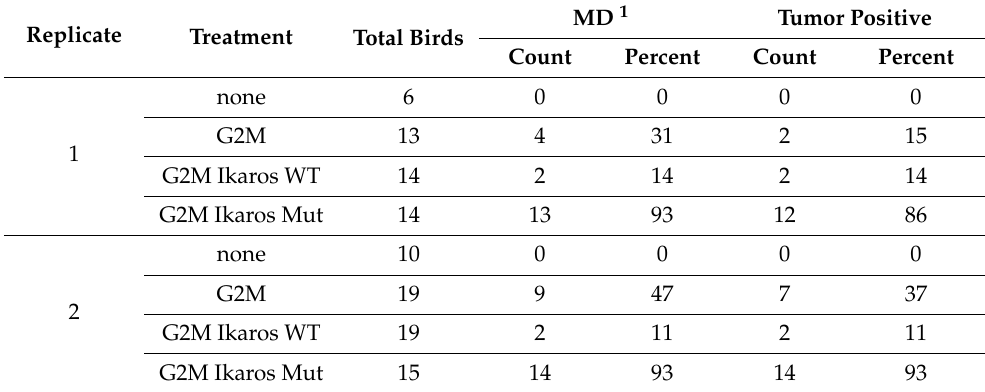
Table 2. Tumor incidence in control birds or those infected with various recombinant MDVs.